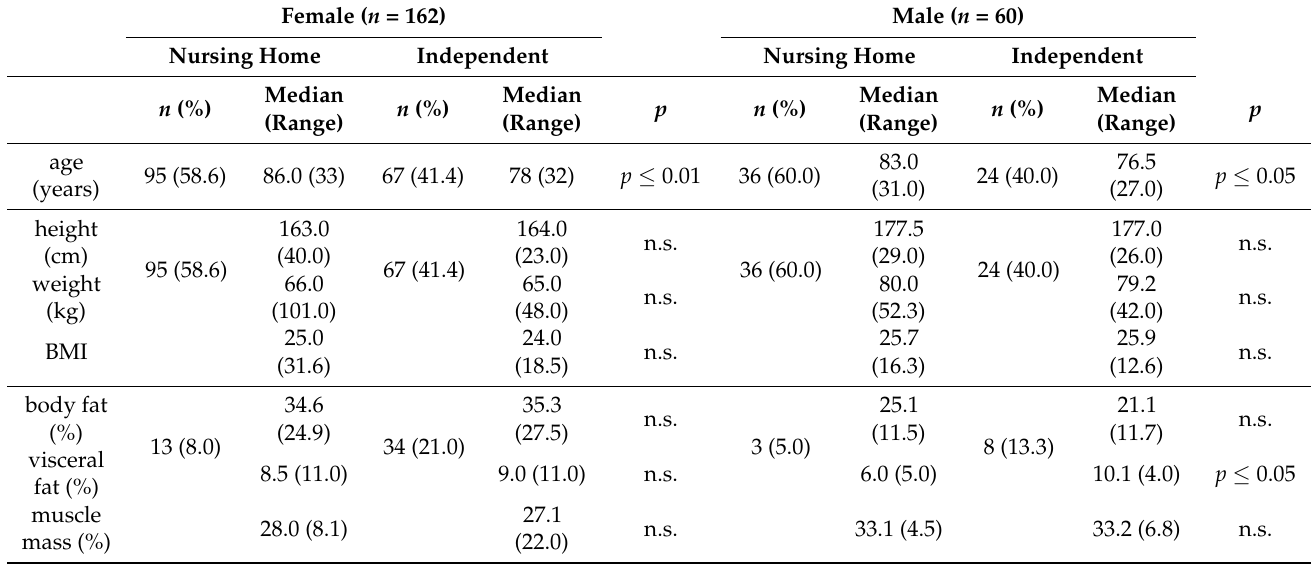
Table 1. Geriatric study population. n = number of participants. n.s.= not significant. Median